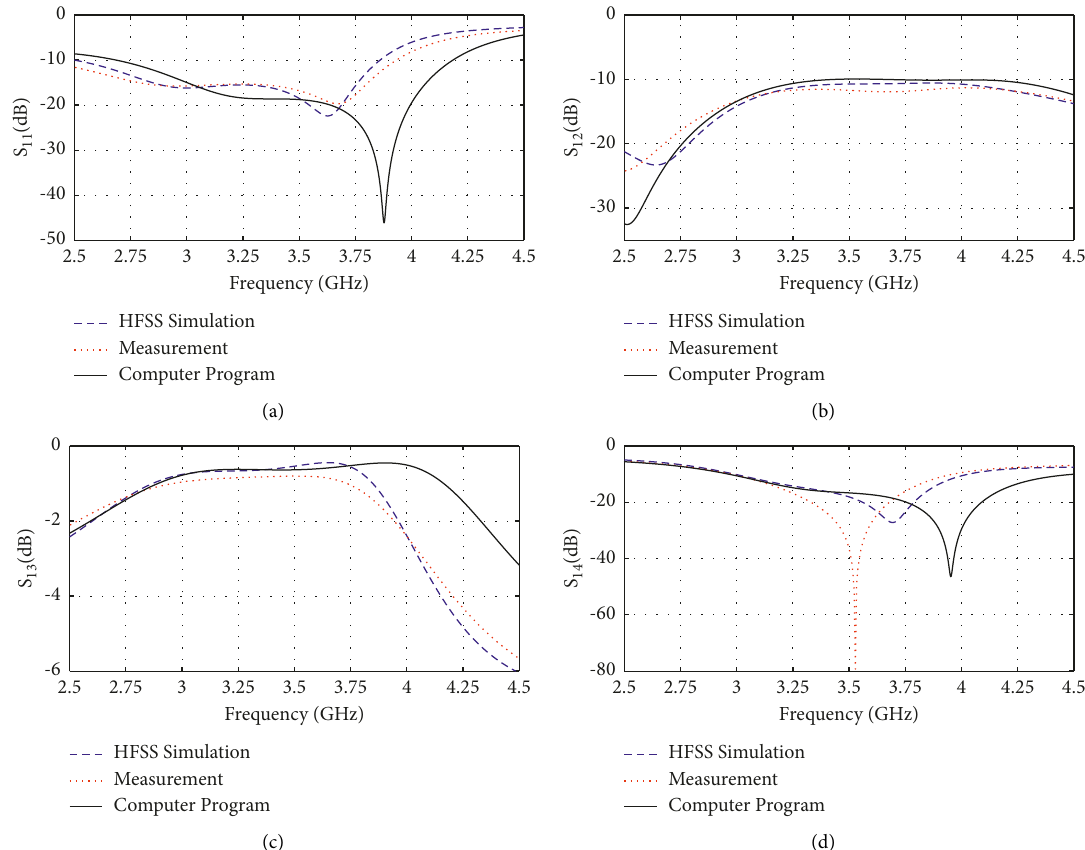
Figure 16: Frequency response of 10dB ATRD coupler. (a) Reflection Loss (b) Coupling coefficient; (c) Through coefficient.; (d) Isolation coefficient.